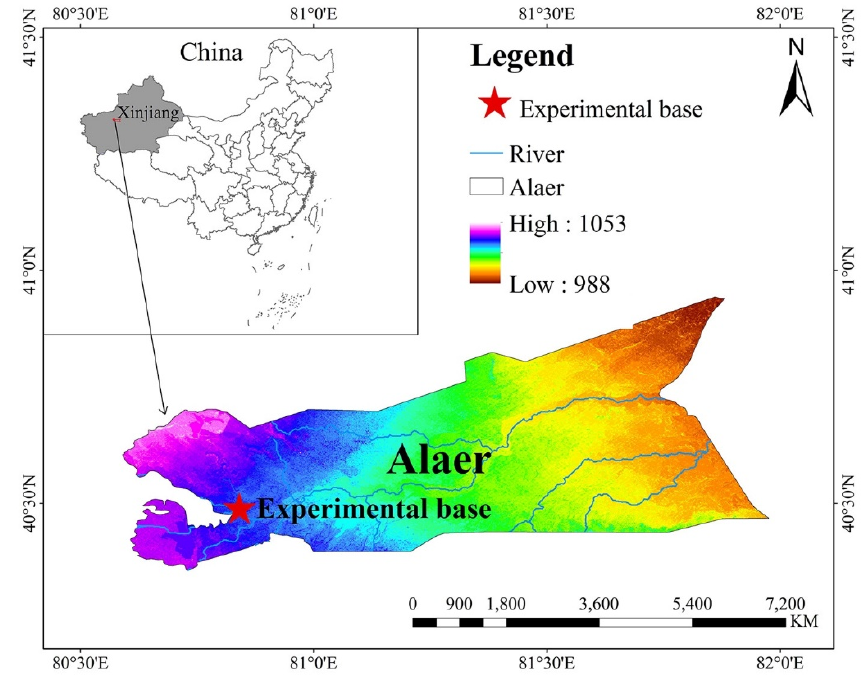
Figure 1. Location of the experimental base.